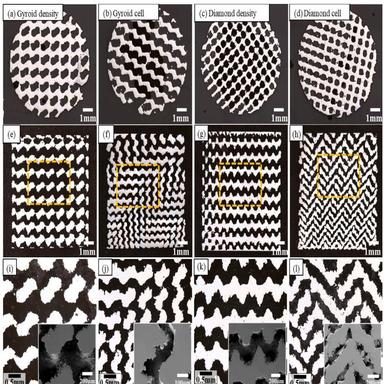
OM and SEM images of four different types of TPMS structures: (a, e and i) relative density grading of gyroid, (b, f and j) cell size grading of gyroid, (c, g and k) relative density grading of diamond and (d, h and l) cell size grading of diamond. Corresponding enlarged OM and SEM images are labeled (i, j, k, l).